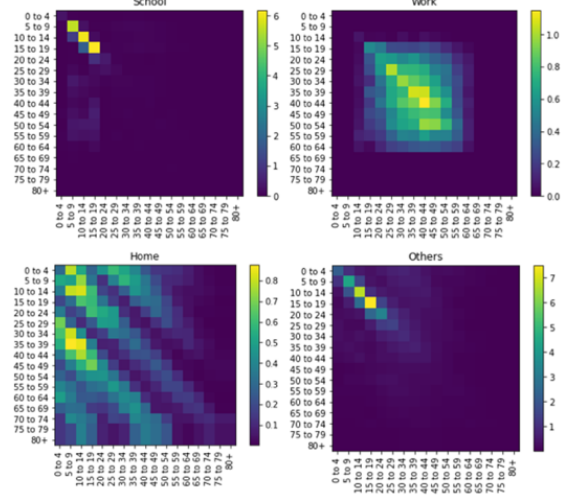
Figure 1. Social Contact Matrices: School, Work, Home, and Others from the Philippines (Prem et al., 2018)